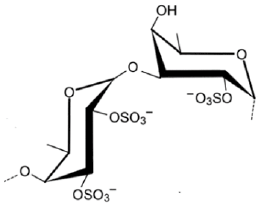
Figure 2. Example of a fucoidan structure.